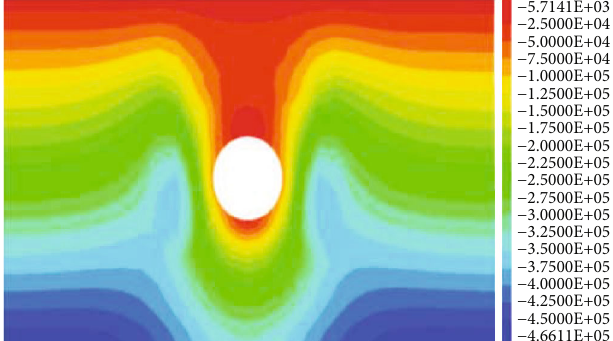
Figure 15: Vertical stress cloud after excavation.